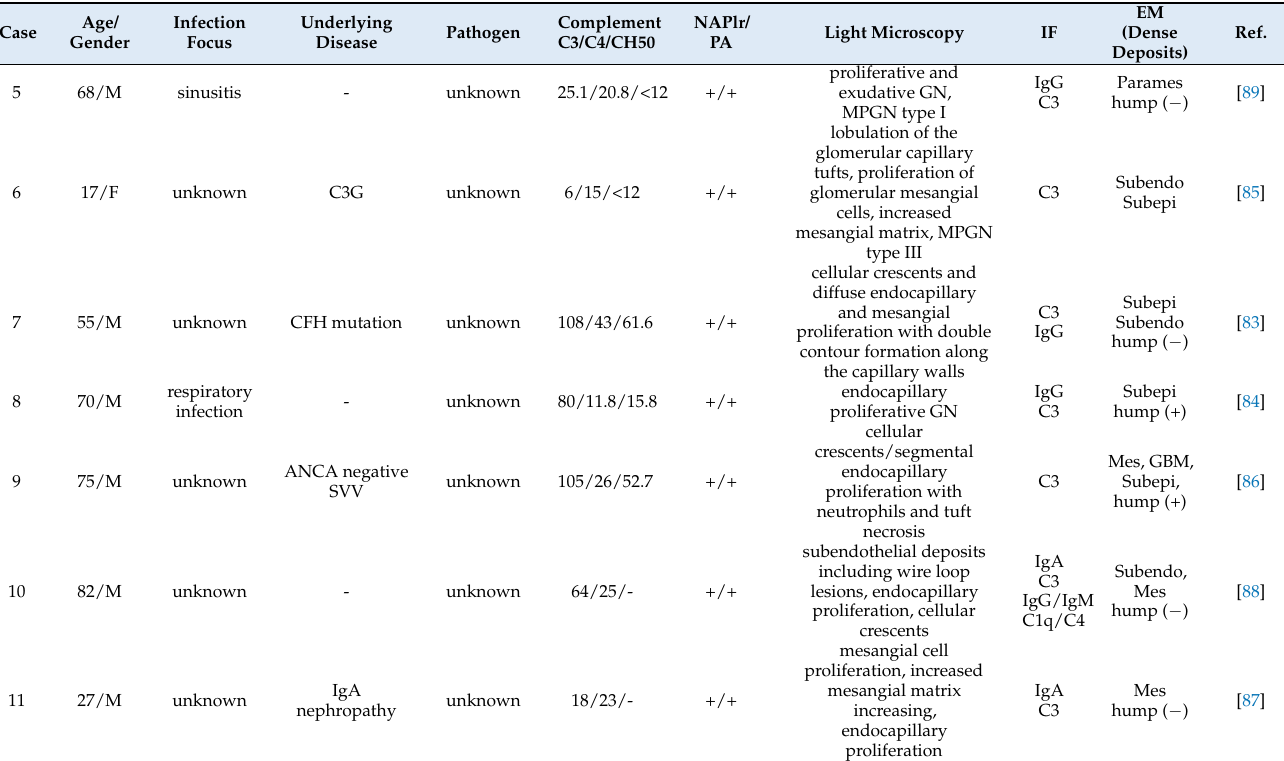
Table 8. Clinical and pathological profiles in patients with IRGN induced by either no or unknown pathogens who were positive for NAPlr and plasmin